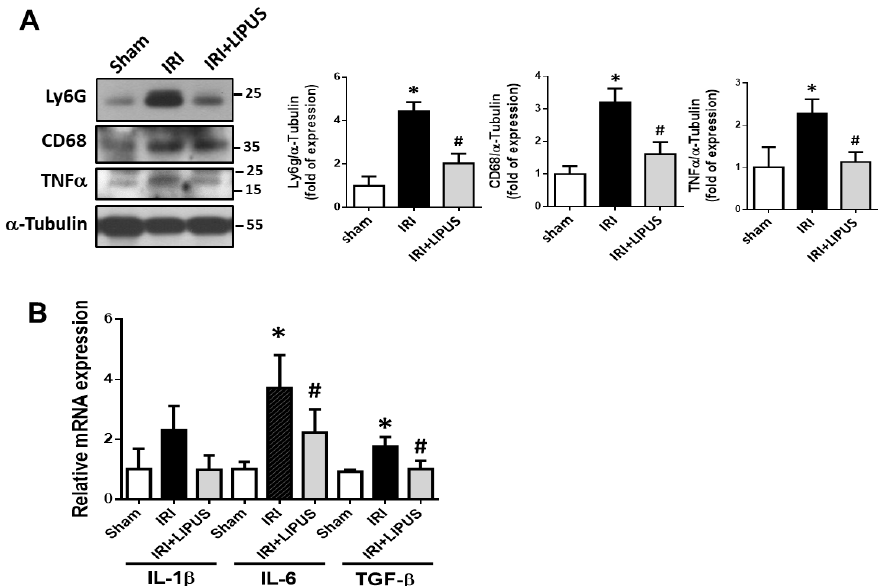
Figure 4. The effects of LIPUS on inflammatory cell infiltration in the kidneys of IRI-CKD mice: Ly6G, CD68, and TNF- α protein expression levels in the kidneys, determined by Western blot ( A ); IL-1 β , IL-6, and TGF- β mRNA expression levels in the kidneys, determined by real-time PCR ( B ). Data are presented as mean ± SD (n = 4–6): * p < 0.05 versus the control group; # p < 0.05 versus the IRI-CKD group.